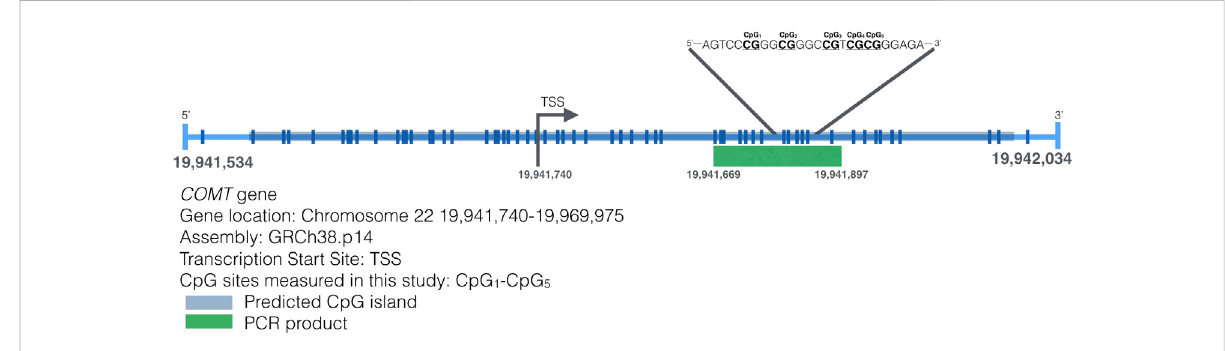
FIGURE 1 Mapofthetranscriptionstartsiteofthe MB-COMT geneandtheCpGsitesonthatregion.A500bpsequencearoundtheTSSofthe COMT gene is presented. Lines represent CpG sites in the sequence. The inset highlights a sequence that includes the CpG sites measured in this